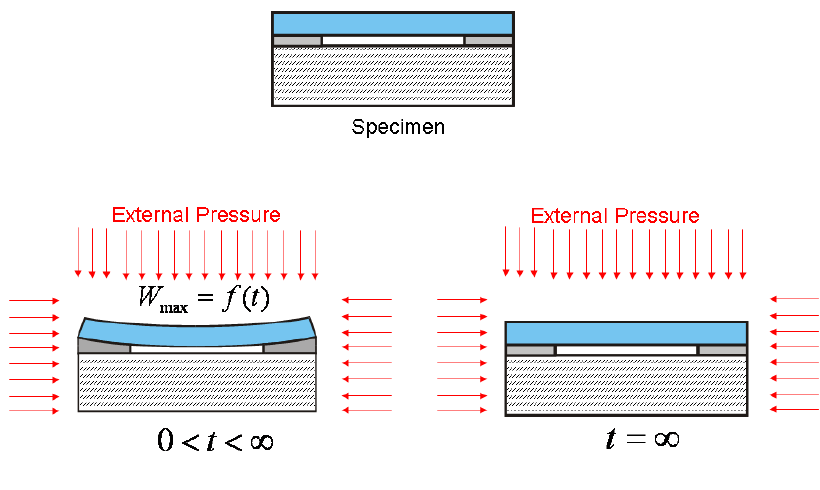
Figure 8. Schematic illustration of the optical leak